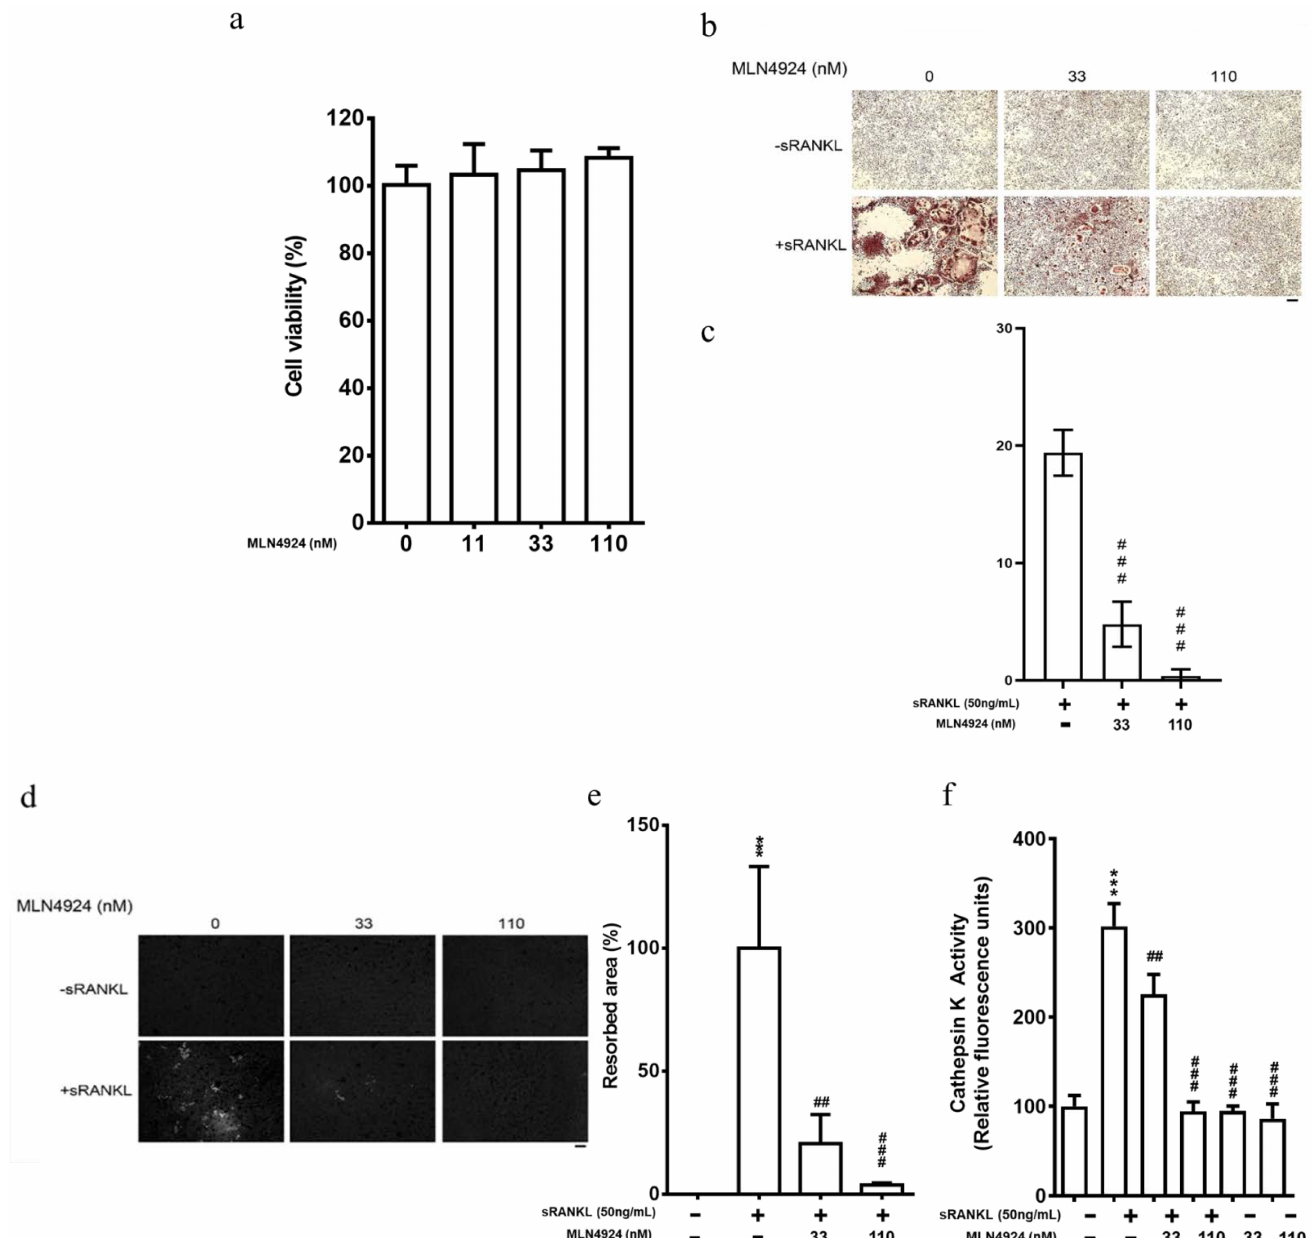
Figure 3. MLN4924 attenuates soluble receptor activator of nuclear factor- κ B ligand (sRANKL)- induced osteoclast differentiation derived from bone-marrow-derived macrophage (BMM) in vitro. BMMs were seeded into 96-well plates, and cultured with sRANKL (100 ng/mL) and M-CSF (40 ng/mL), and indicated the concentration of MLN4924 for 7 days. ( a ) The viability of BMMs was determined using the CCK-8 assay after treatment with M-CSF and various concentrations of MLN4924 for 7 days. In a 24-well plate, osteoclasts were identified through TRAP staining ( b ). The TRAP-stained positive giant osteoclasts were quantified ( c ). The cells were removed from the Corning Osteo Surface 96-well plate and visualized with 1% toluidine blue ( d ). All photographs were captured using an inverted microscope at a magnification of 100 × . Quantification of the resorbed area ( e ). Treated cells were harvested and subjected to cathepsin K activity detection ( f ). Scale bar represents 100 µ m. *** compared with control p < 0.001, ## compared with sRANKL, p < 0.01; ### compared with sRANKL, p <